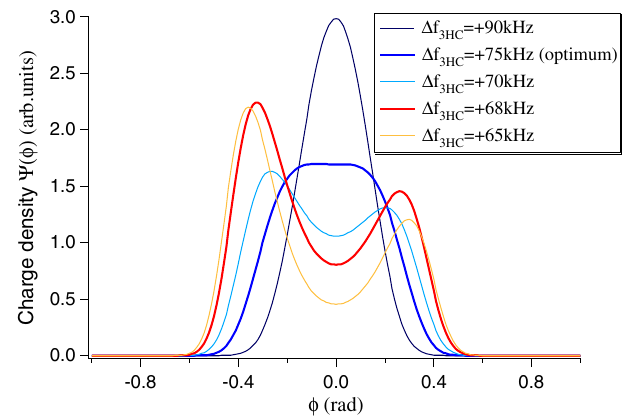
FIG. 15. (Color) Nominal charge density in the bunch in func- tion of the 3HC detuning, calculated in uniform filling and at 315 mA by using formula (9).